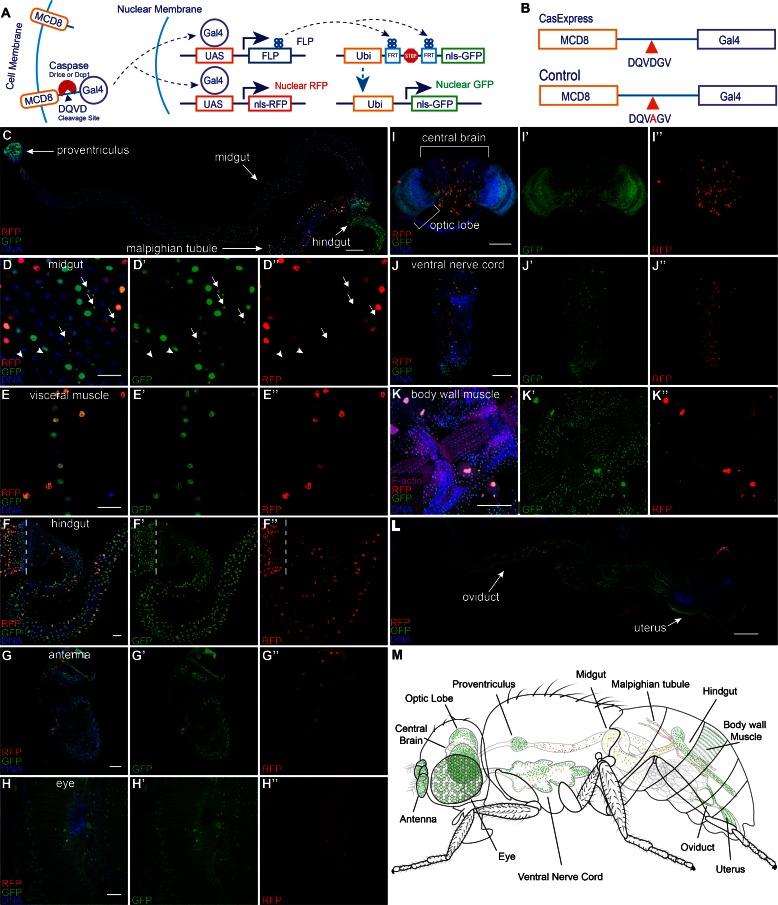
Widespread CasExpress activation in adult tissues.(A) A schematic of CasExpress and G-trace. (B) A schematic showing the sequence of the DQVD caspase cleavage site in CasExpress and the point mutation in the DQVA control. (C–L) Confocal micrographs showing overlays of DAPI, RFP and GFP from CasExpress/G-Trace flies. (D’–L’) GFP channel only. (D”–L”) RFP channel only. Arrows in D–D’’ indicate examples of GFP+ progenitor cells, and arrowheads point to examples of GFP- progenitor cells. Dotted lines in F–F’’ mark the boundary between midgut and hindgut. Scale bars in C and I-L are 100 μm; scale bars in D–H are 25 μm. (M) A schematic summarizing the general pattern of GFP and RFP expression in adult. Although GFP expression was present in all body wall muscle, only part is shown in green for simplicity and presentation clarity.